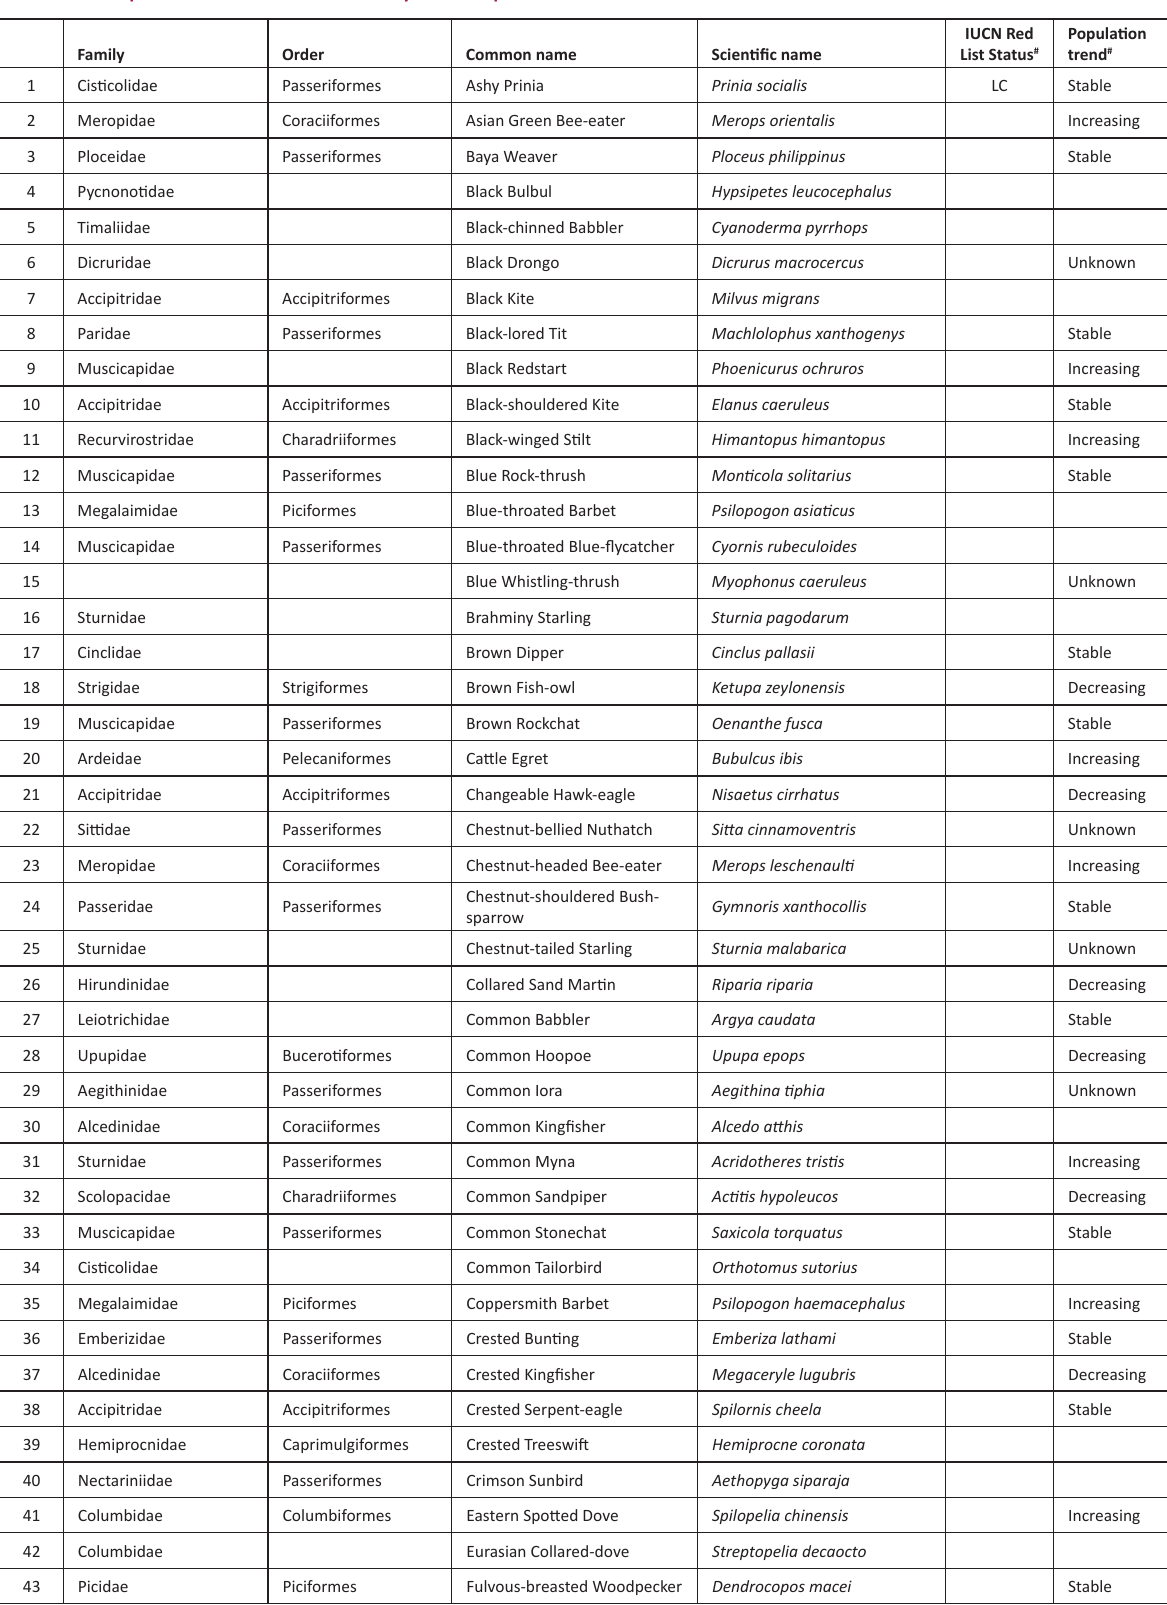
Table 2. Avian species recorded from all the study sites in alphabetical